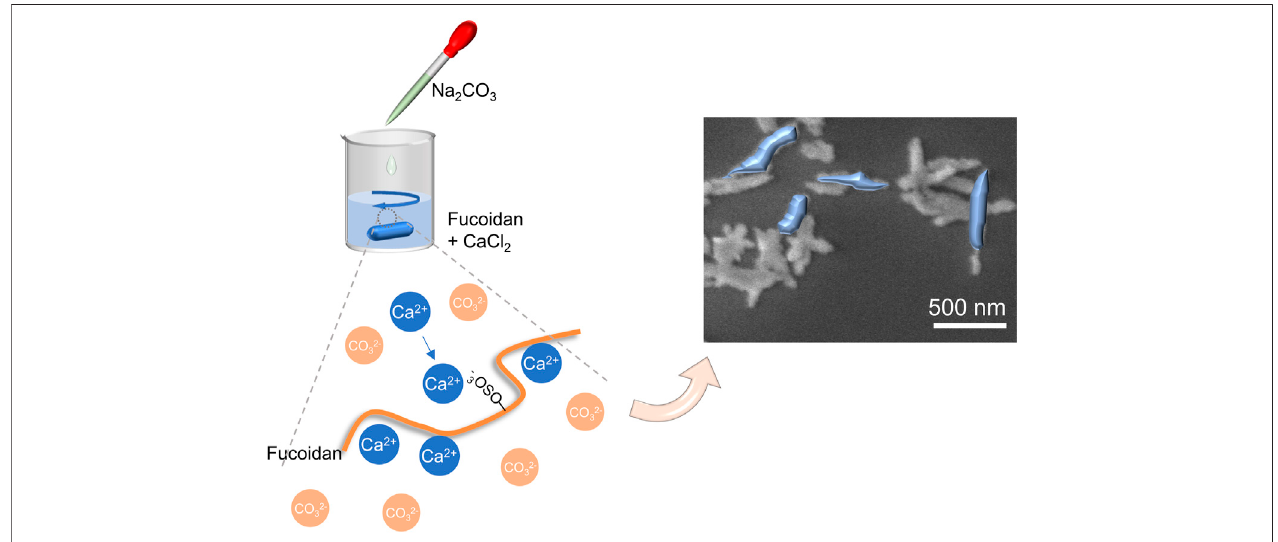
FIGURE 1 | Schematic diagram of the synthesis of CaCO 3